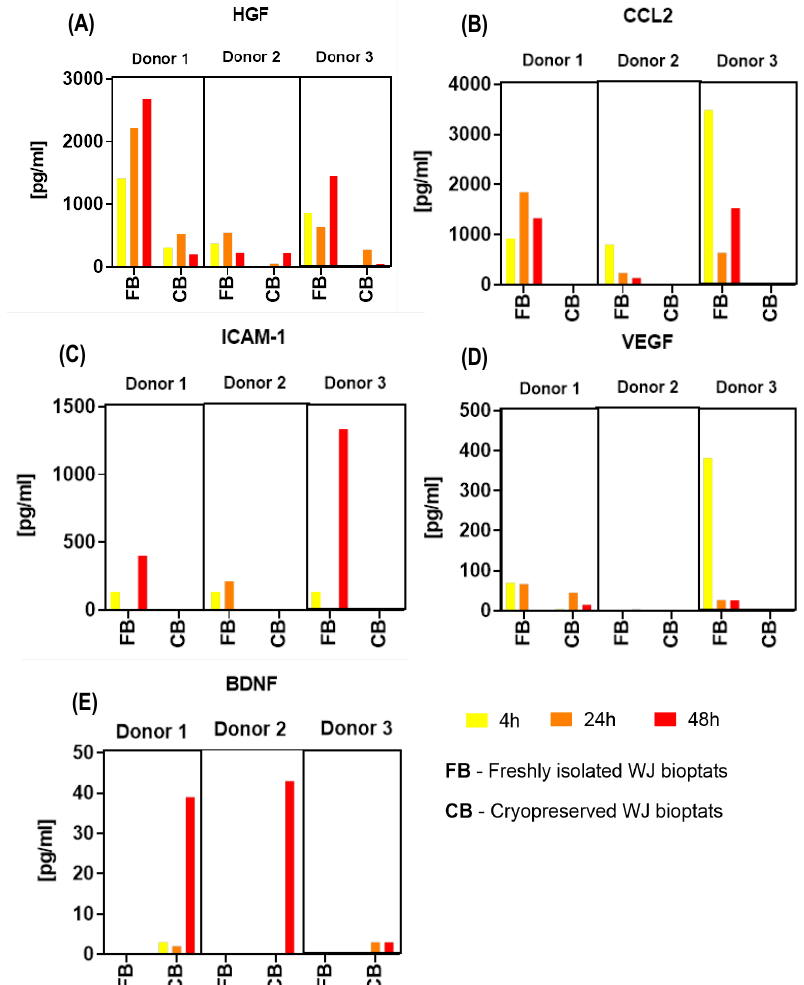
Figure 5. Comparison of the soluble secretomes of freshly isolated WJ bioptats and cryopreserved WJ bioptats. The results are presented as mean ± SD for each of the donors ( n = 3). Secretion of ( A ) HGF, ( B ) CCL2, ( C ) ICAM-1, ( D ) VEGF, and ( E ) BDNF.